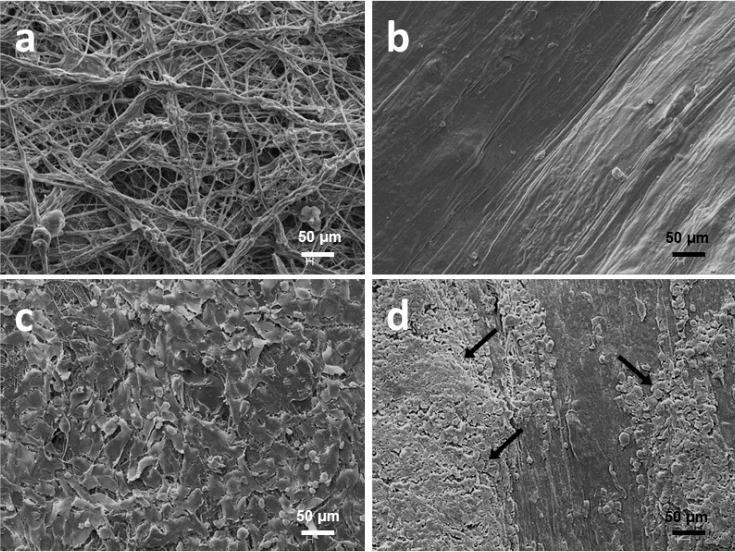
Figure 11. Scanning electron microscopy (SEM) analysis of polyurethane ( a ) and collagen ( b ) before ( a + b ) and after ( c + d ) rotational seeding. Whilst PU shows cell adherence all over the scaffolds surface ( c ), collagen ( d ) is seeded only partially